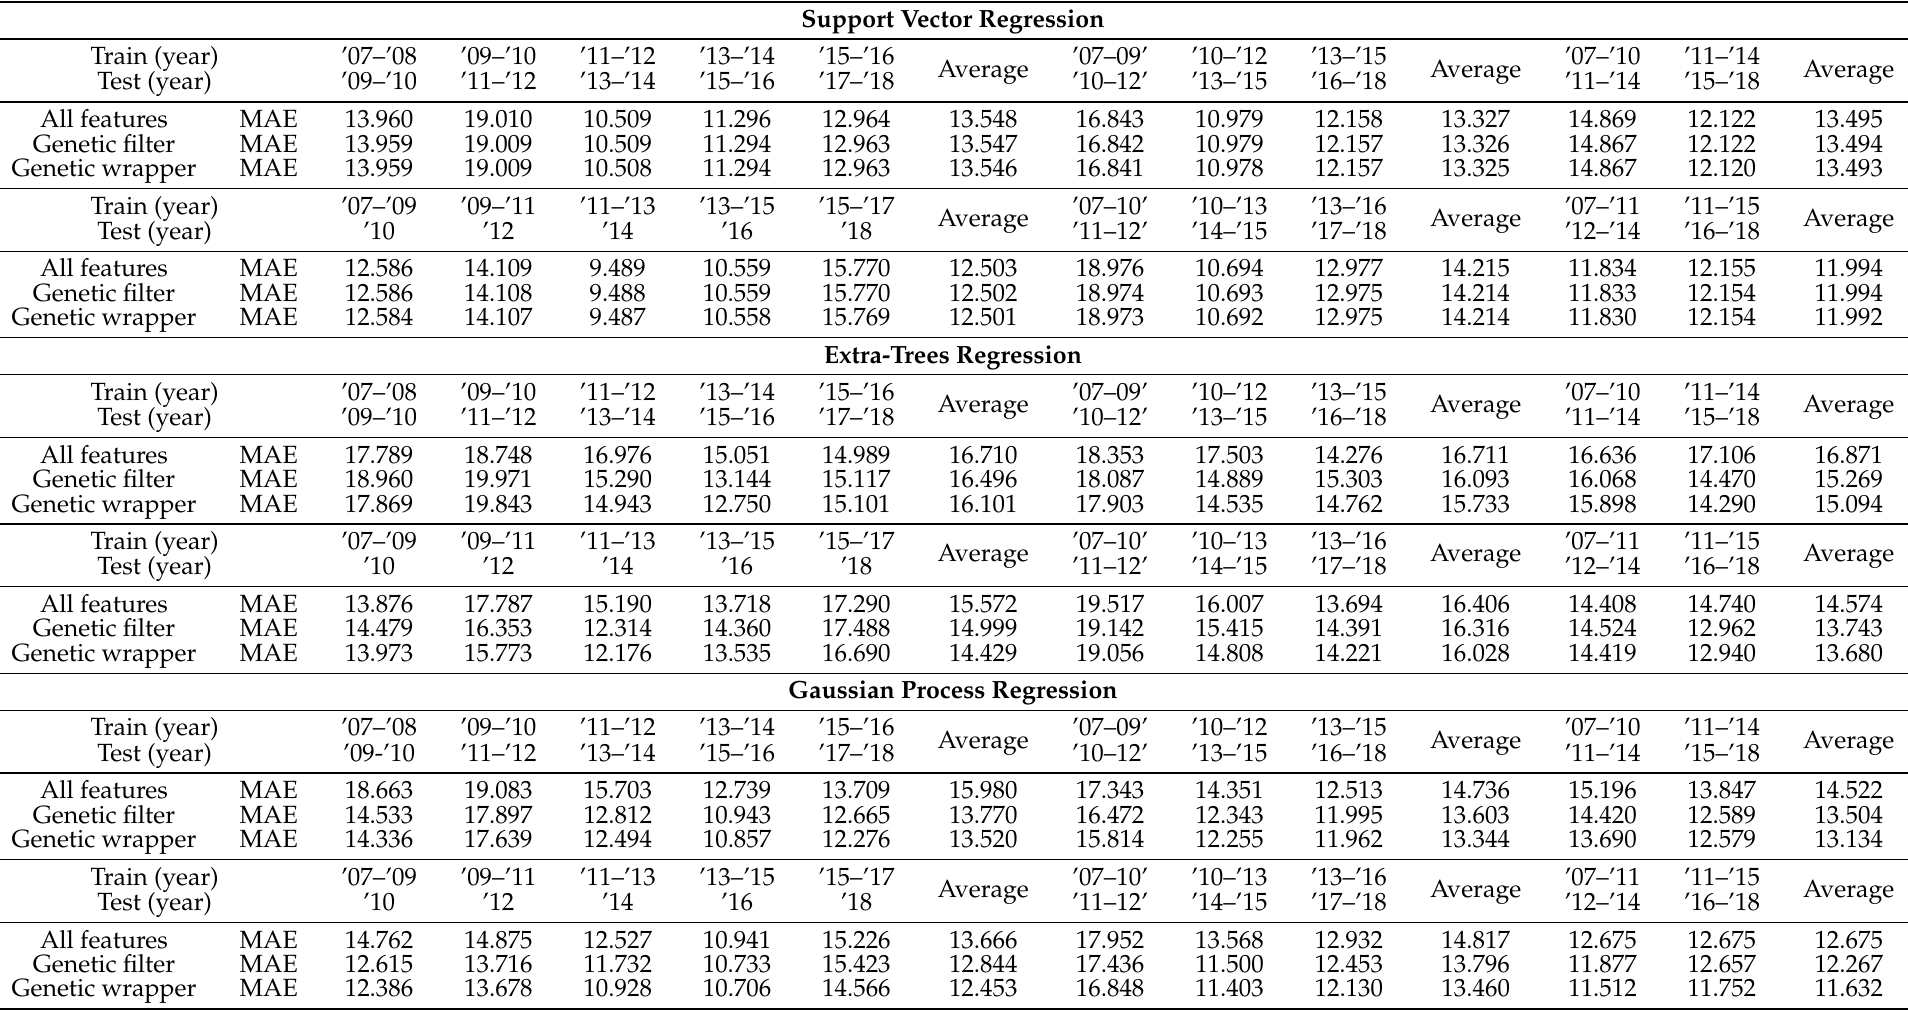
Table A2. Results of applying feature selection to the net changes of